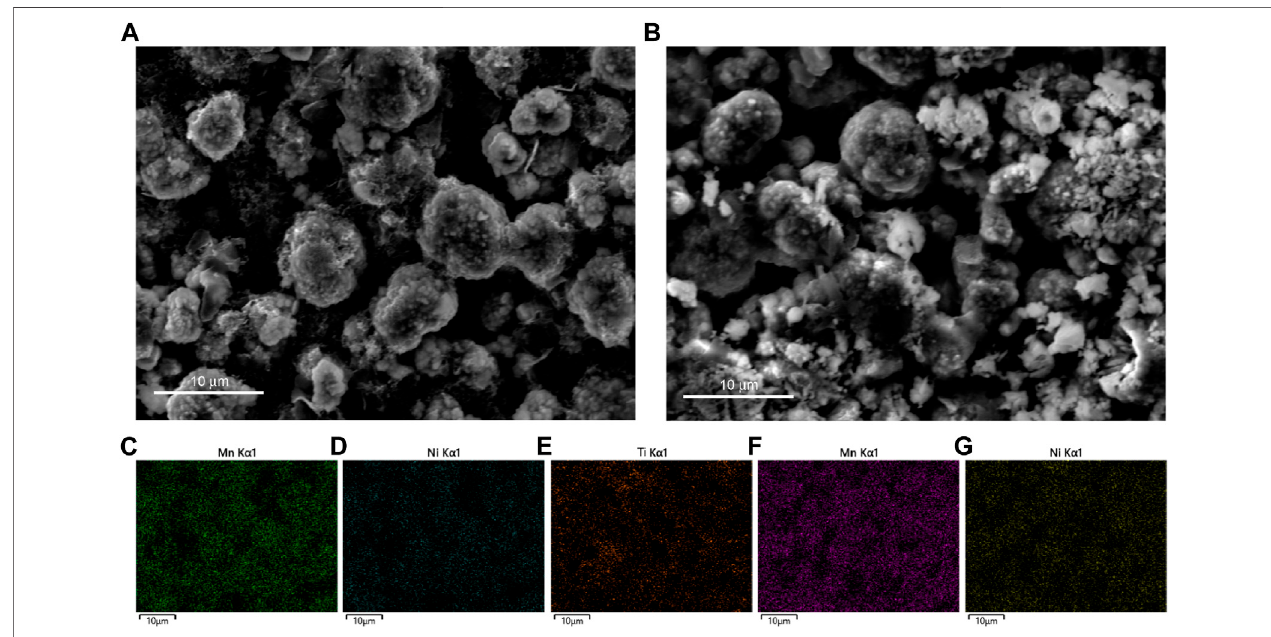
FIGURE 5 | SEM and EDS mapping images of Li 4 Ti 5 O 12 – coated Li 1.1 Ni 0.35 Mn 0.55 O 2 (A,C,D,E) and Li 1.1 Ni 0.35 Mn 0.55 O 2 cathodes after cycles (B,F,G) .